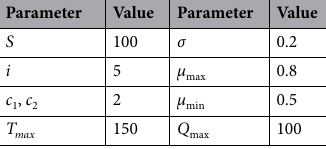
Table 5. Simulation parameter setting.